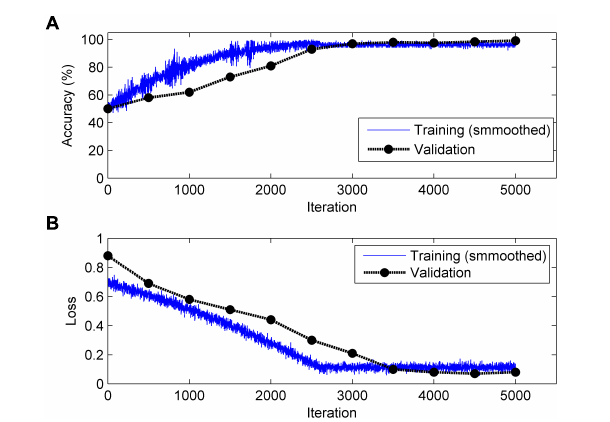
practice, the accuracy (Acc), sensitivity (Se) and specificity (Sp) are specifically employed to assess the classification algorithms, as shown in Equations (7) to (9). The Se points out the performance of the model on the detection of normal fetus whereas the Sp measures the performance of the system on detecting a hypoxic fetus. In addition, the area under (AUC) the receiver operating characteristic (ROC) curve is also useful for obstetricians.